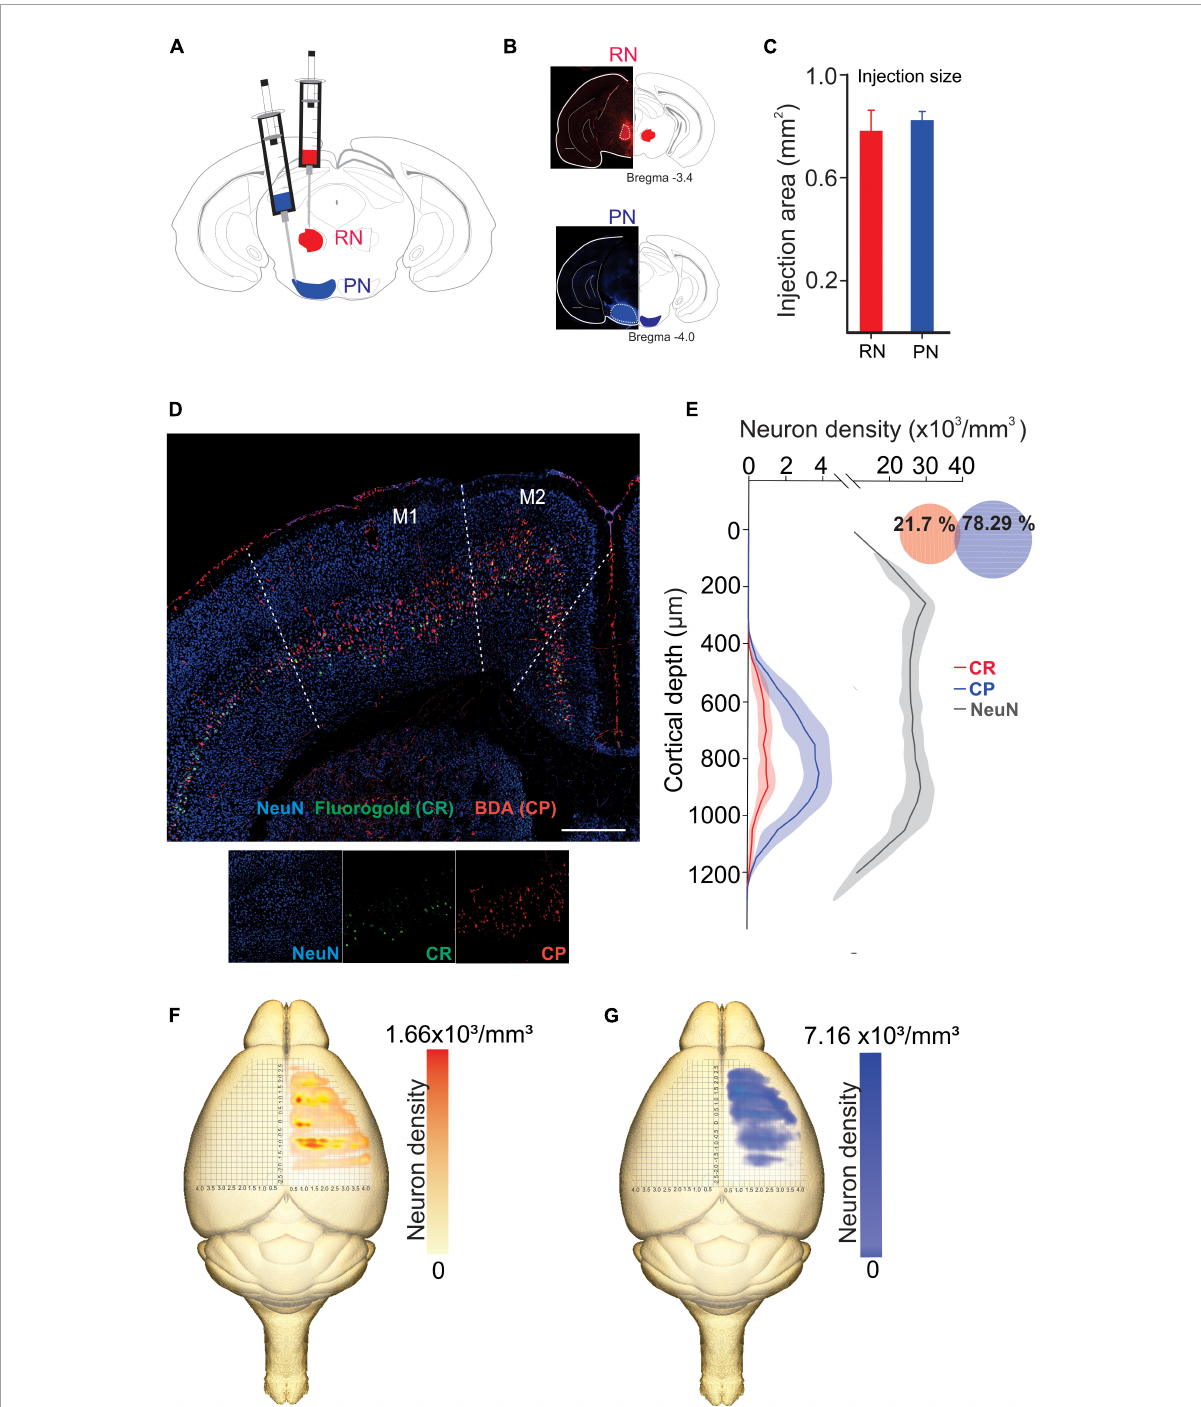
FIGURE1 Distinct population of PTNs projecting to the RN and PN. (A) Retrograde tracers FG and ChT 594 were simultaneously injected into the RN and PN, respectively. (B) Examples of injection sites from the same animal. (C) Comparison of the injection extent, measured as the transversal area covered by the tracer [dashed lines in (B) ], in 3 mice (RN = 0.7 ± 0.08 mm 2 , PN = 0.8 ± 0.03 mm 2 ). (D) Coronal mosaic photomicrograph showing the distribution of CR (green) and CP (red) PTNs and NeuN (blue) in M1. Below detailed images of the 3 channels showing the cortical neurons. (E) Average vertical distributions of the CR (red) and CP (blue) PTN somata computed for 3 mice (3 consecutive slices per animal). Gray line represents the distribution of NeuN-labeled cells in the same experiments. Proportion of CR, CP, and double-labeled neurons (0.7 %) in M1 are indicated in the Venn diagram. (F,G) Averaged relative density representation maps ( n = 3 animals) in the horizontal plane of the CR (F) and CP (G) neurons. Neuron density is expressed as the mean number of retrograde labeled neurons (neurons/voxel 250 mm 3